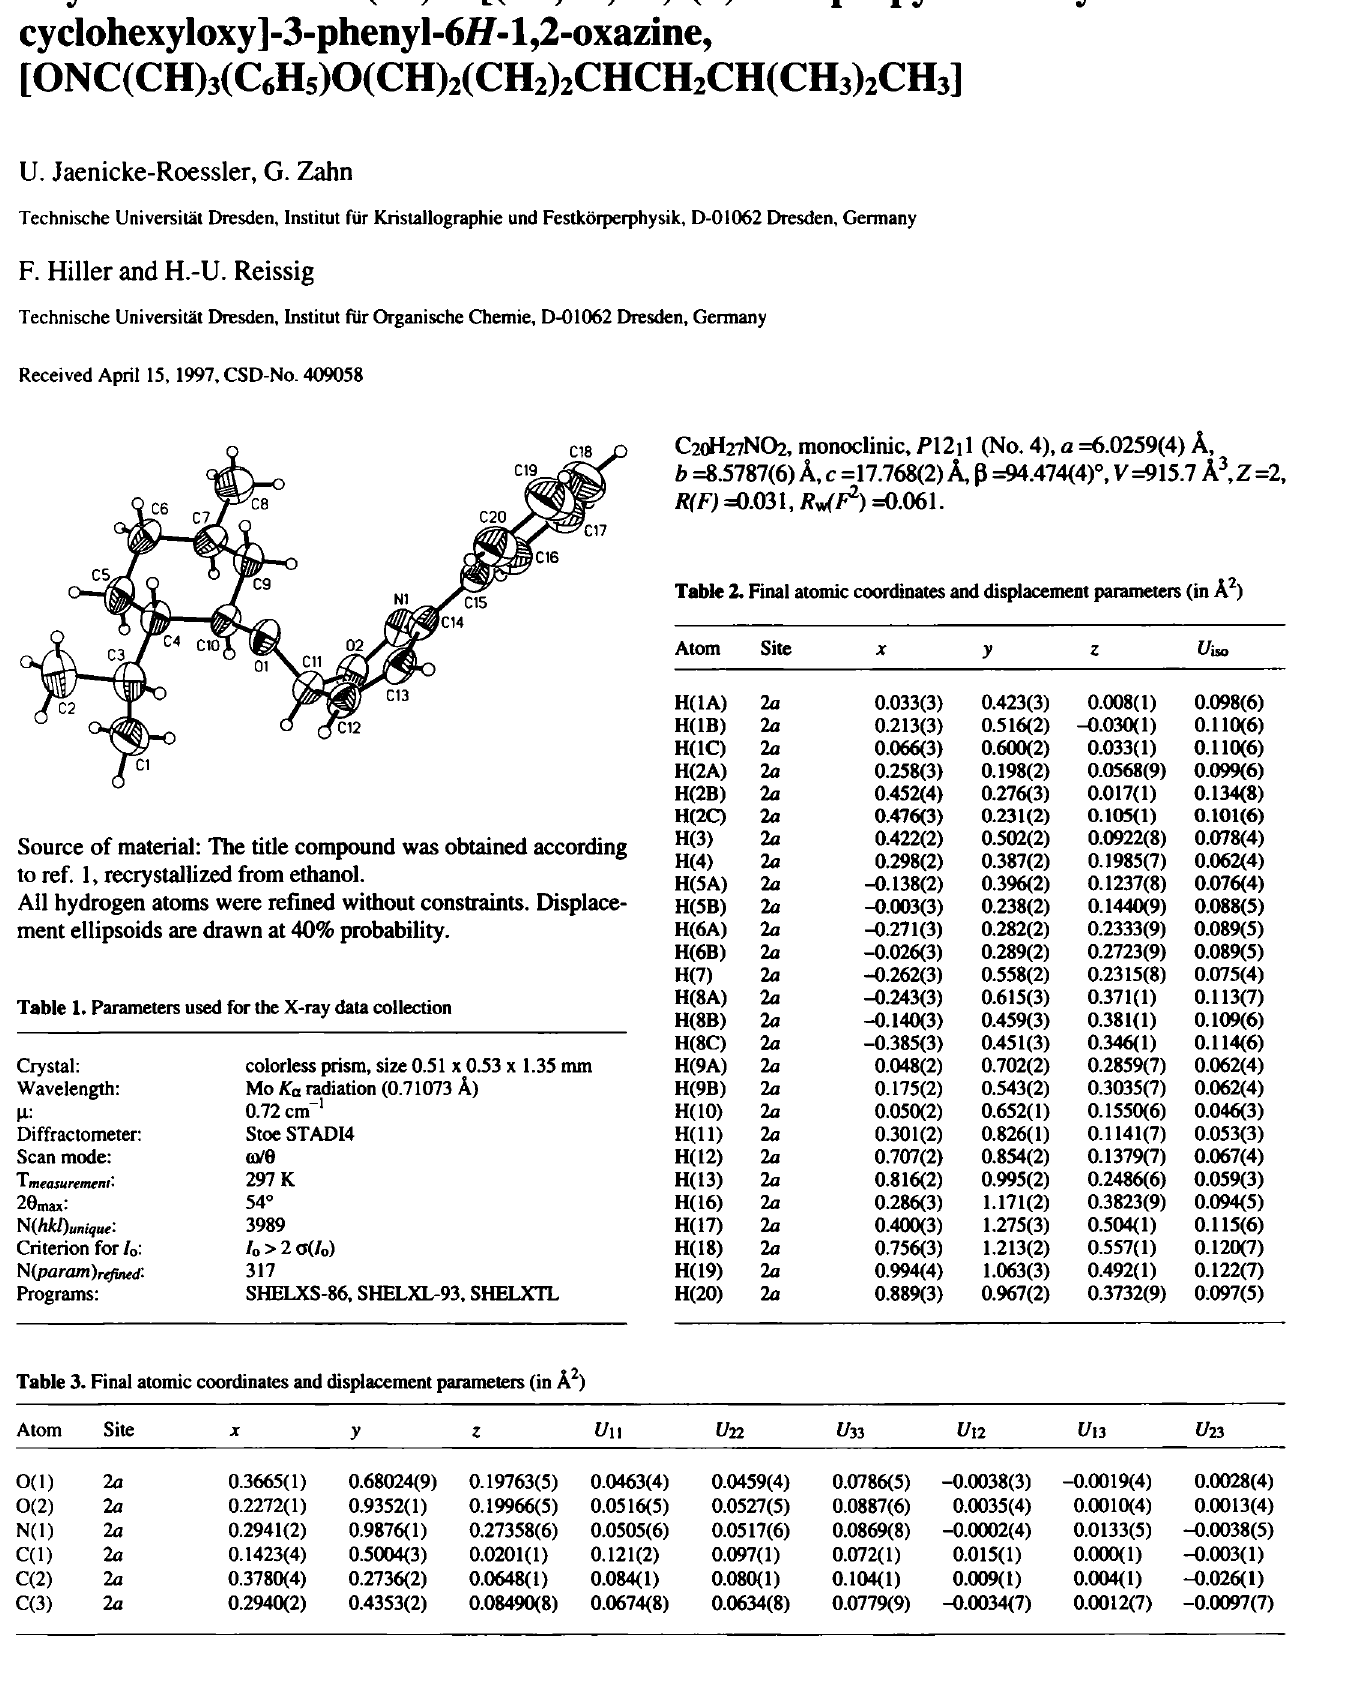
Table 3. Final atomic coordinates and displacement parameters (in